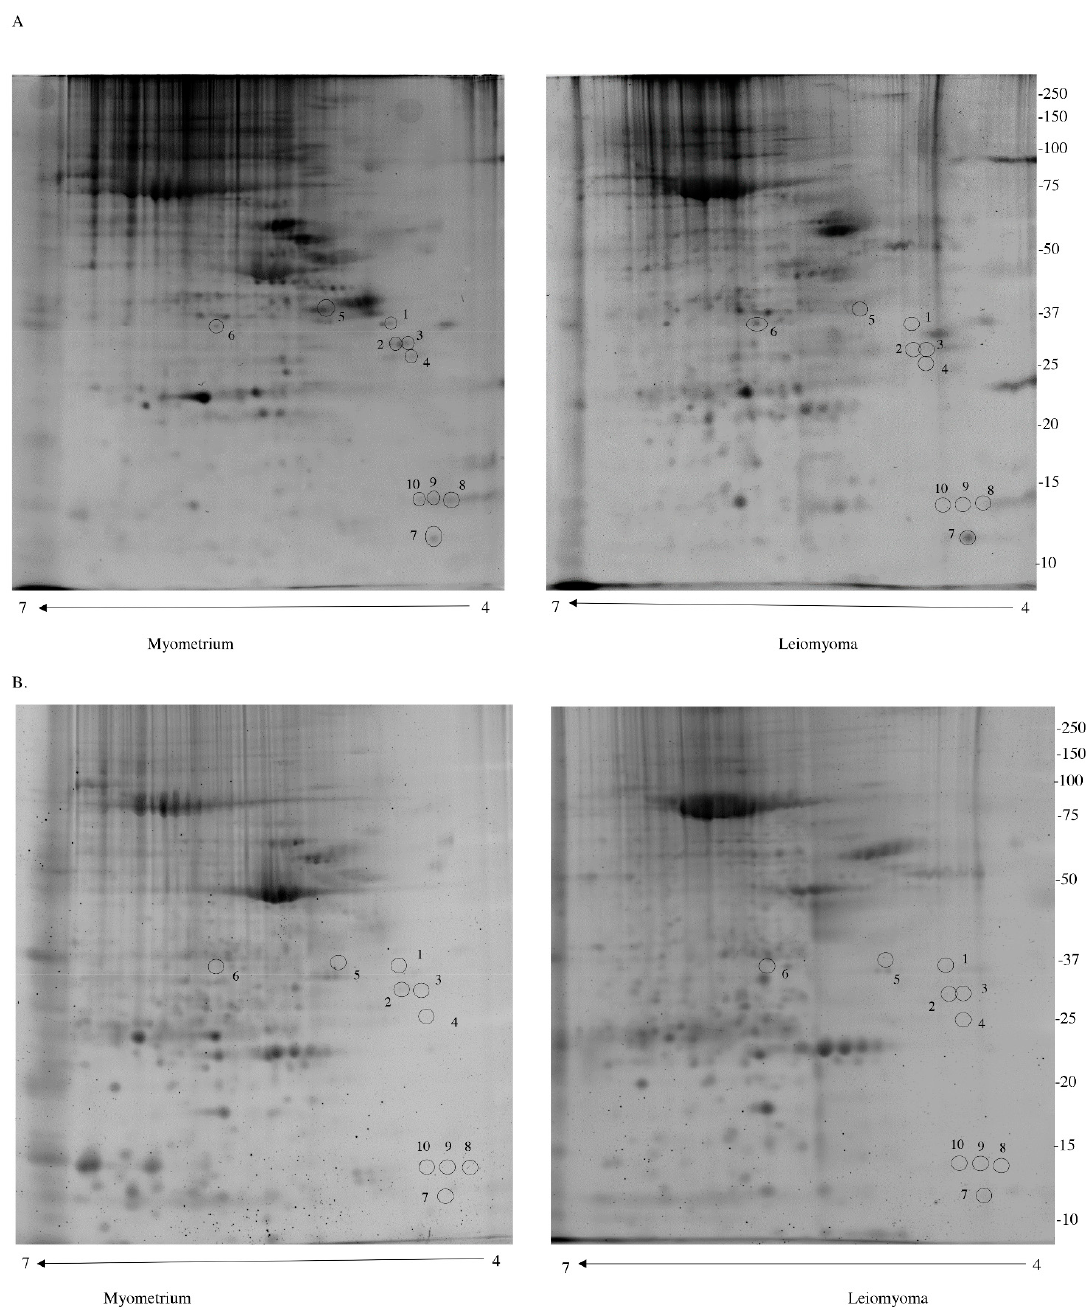
Figure 1. A. Images of gels stained with Pro-Q Diamond to detect phosphoproteins. B. Images of gels stained with SYPRO Ruby for total